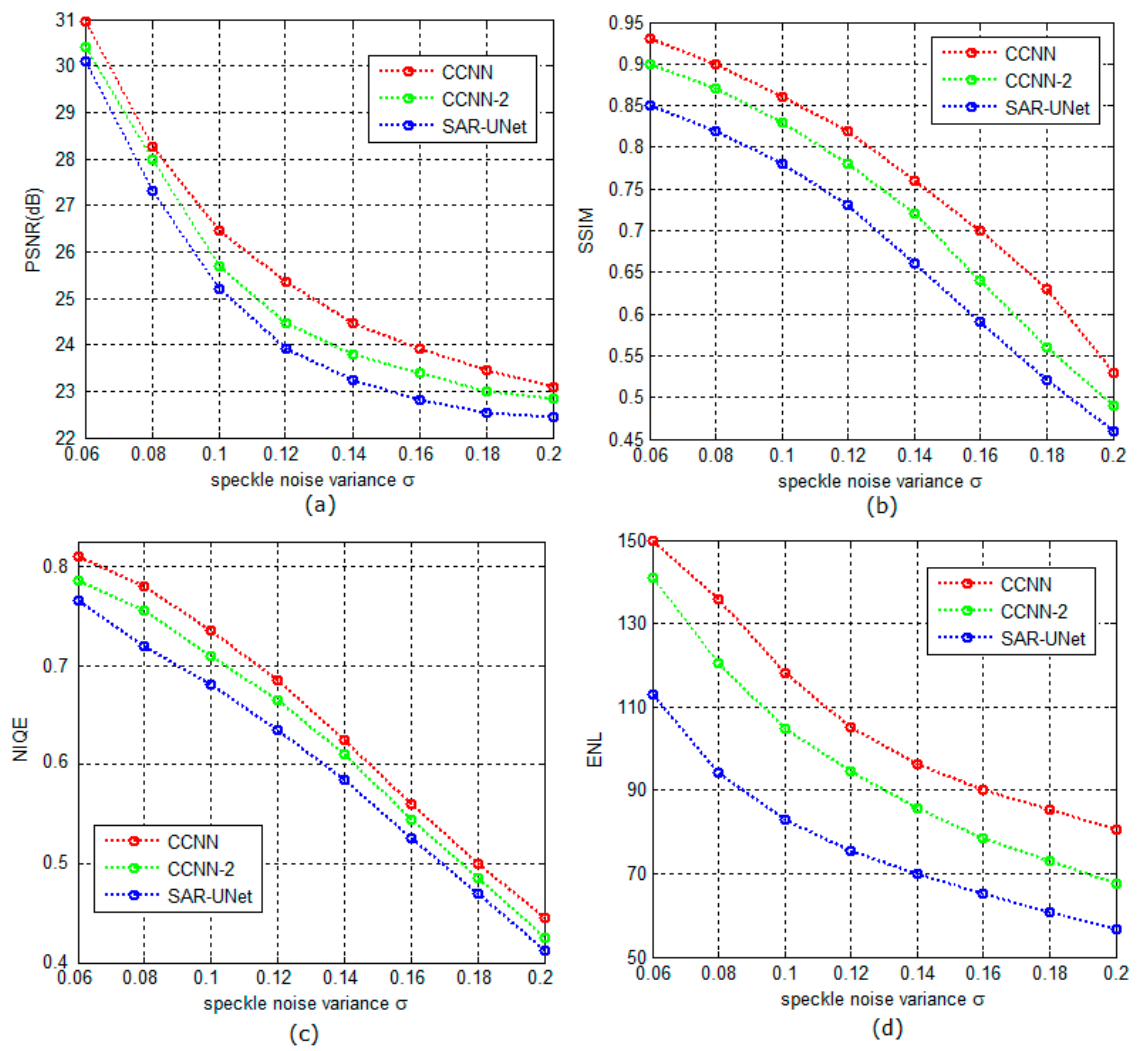
Figure 3. Study of the subnetwork structure of the CCNN. ( a ) PSNR; (b) SSIM; ( c ) NIQE; ( d ) ENL.